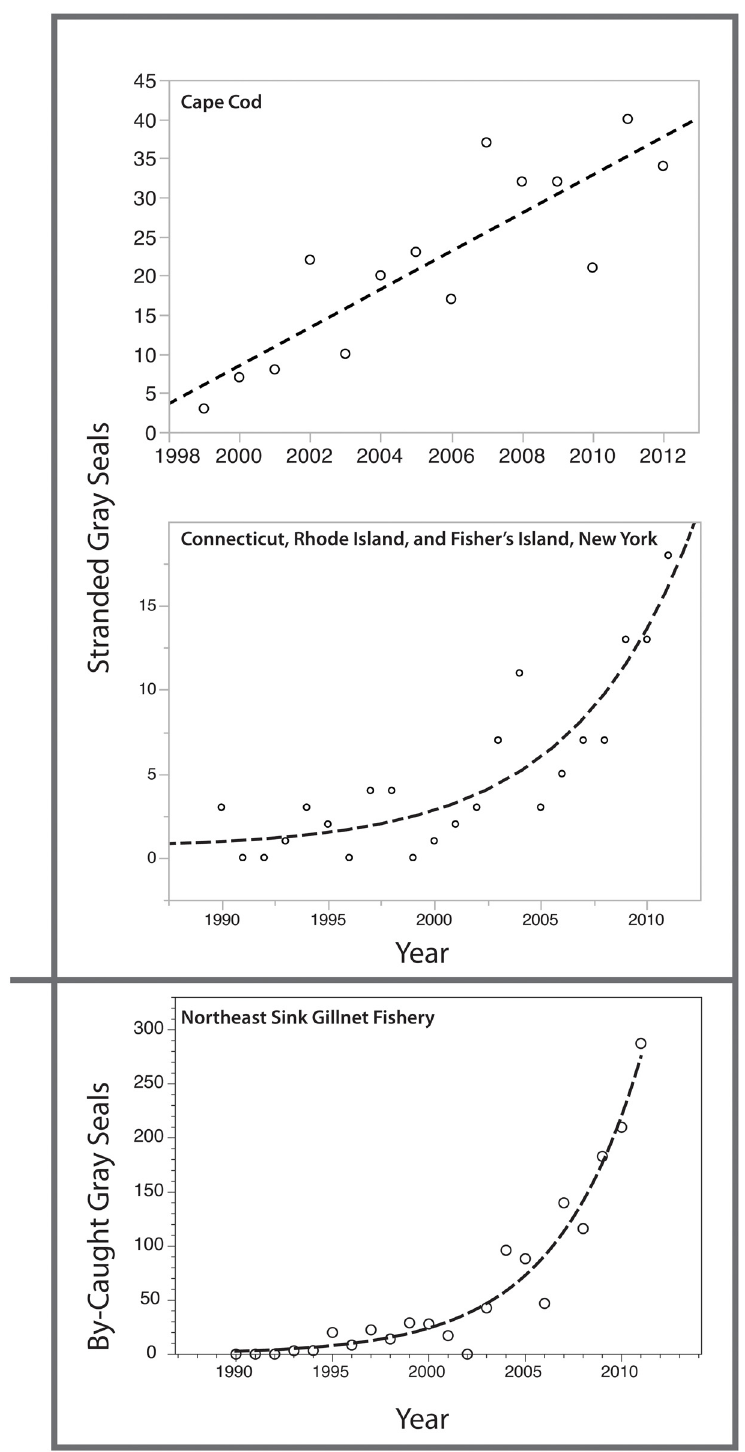
Fig 1. Strandings of gray seals in the Cape Cod and Connecticut, Rhode Island, and Fisher ’ s Island, New York regions, and bycatch for the Northeast Sink Gillnet Fishery. Yearly values indicated by open circles, linear and exponential model fits indicated by dashed